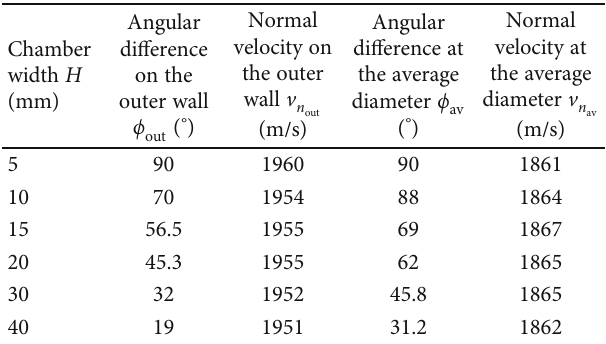
Table 1: Variation of angular di ff erence ϕ and normal detonation